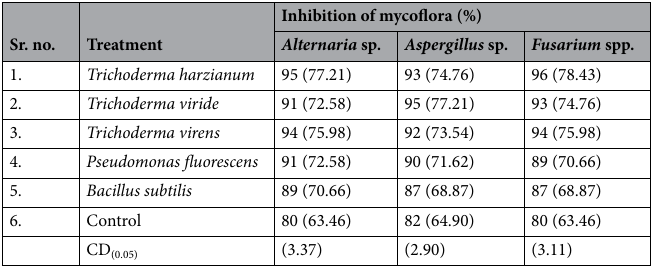
Table 1. Effect of seed treatment with bio agents on seed mycoflora. Figures in the parentheses are arc sine transformed. Statistical analysis was done on opstat software.